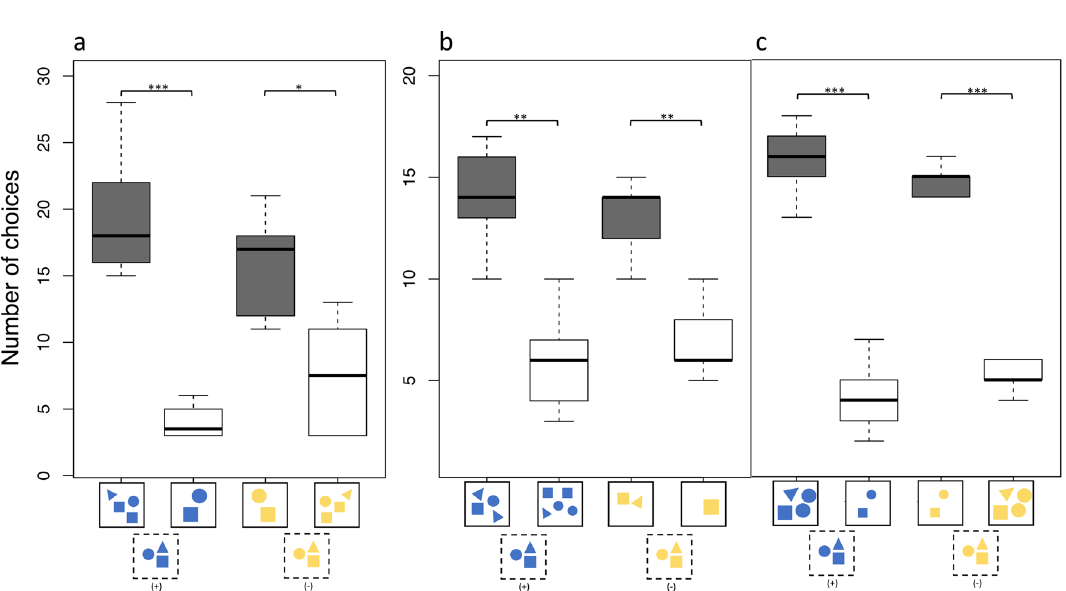
Figure 5. Overview of cichlid (n = 6) choices in all three transfer tests. ( a ) Transfer test type A; ( b ) Transfer test type B; ( c ) Transfer test type C. Schematic examples on which the individuals based their choice are presented on the x-axis. Stimuli in the dashed box show the test stimulus presented first, and solid boxes contain the choice stimuli that followed. Dark bars represent correct choices, transparent bars incorrect ones. p < 0.01*, p < 0.001**, p <